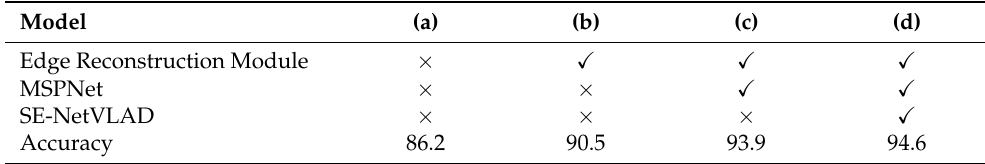
Table 3. Results of ablation